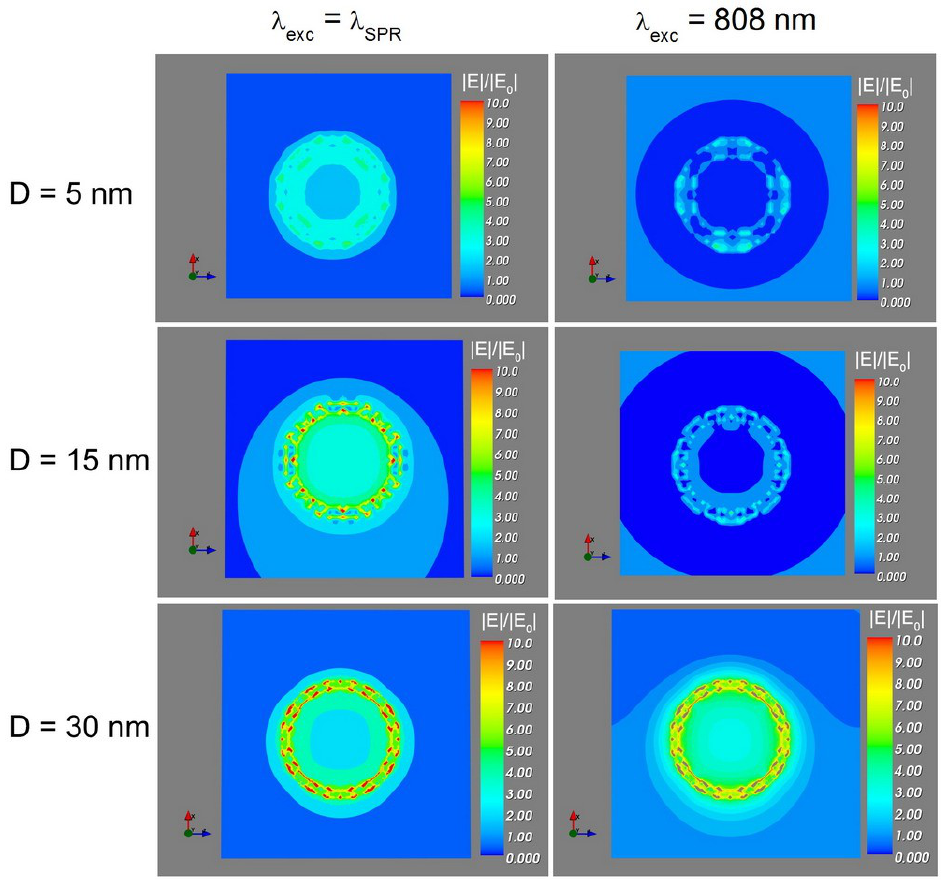
Figure 6. Simulation of the electric field strength (| E |/| E 0 |) of UCNP@mSiO 2 -Au NPs (15 nm– D –5 nm geometry) under the irradiation wavelength λ exc = λ SPR and λ exc = 800 nm, with different silica spacers with thickness D of 5 nm, 15 nm, and 30 nm. | E |/| E 0 | is the enhancement factor. The electric field is amplified in case | E | > | E 0 |.